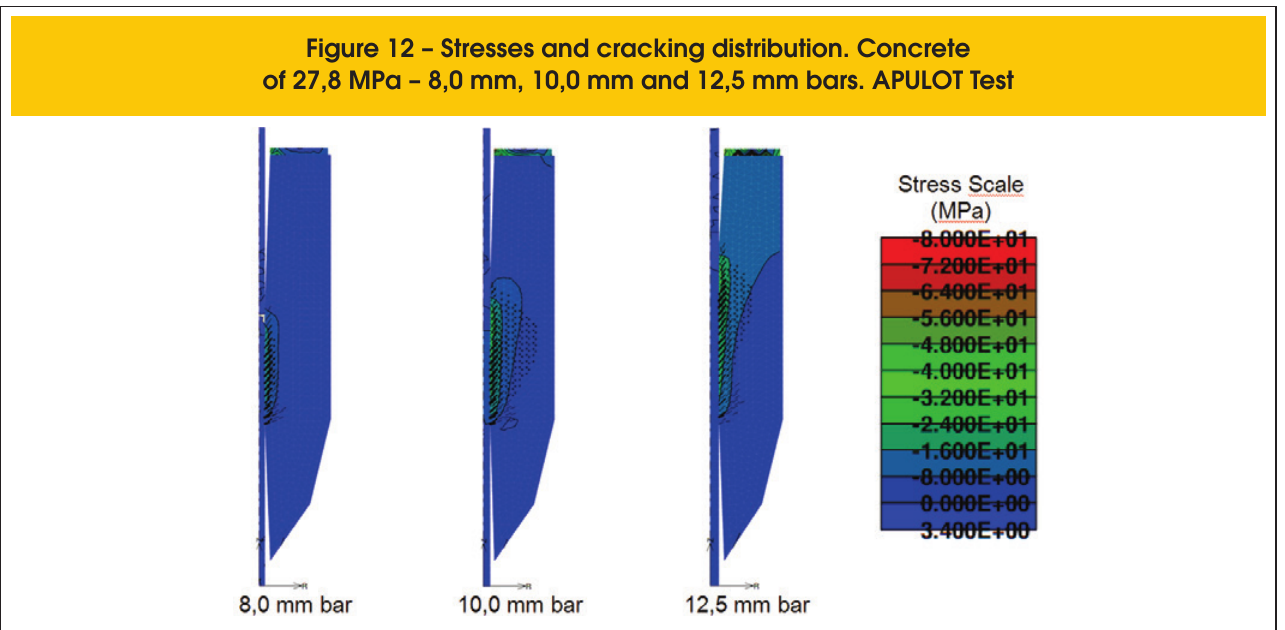
Figure 12 – Stresses and cracking distribution.